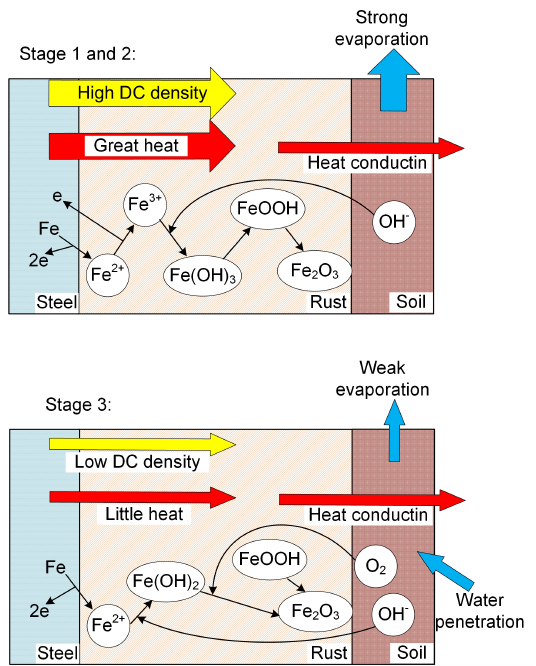
Figure 11. Simplified schematic of corrosion behavior of X80 steel under HVDC interference in sandy